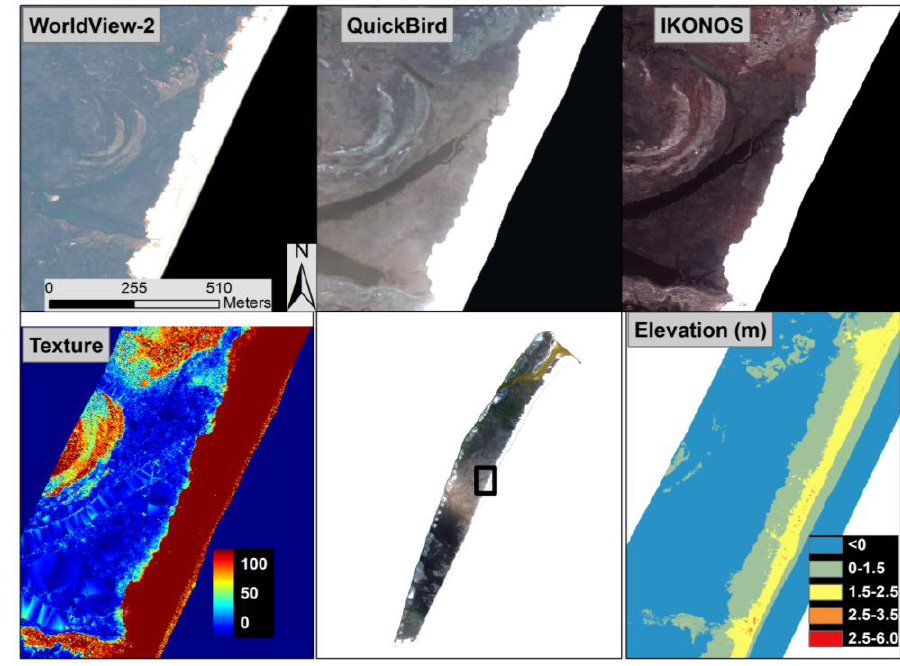
Figure 2. Natural color images and LiDAR texture and elevation for a selected region of Masonboro Island, NC,